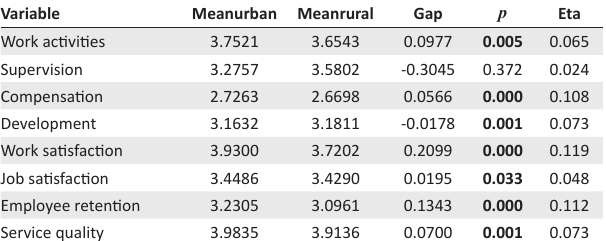
TABLE 2: Gap analyses between the urban and rural sample group based on the mean scores of the measurements.